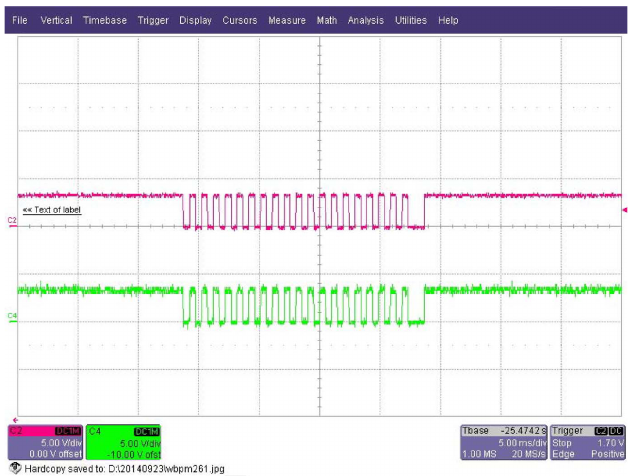
Figure 3 Two channels of control pulse signal output from the SLS2013: one is for the CCD93-70 step motor driver to control the Bragg motor of the DCM, the other is for the input signal of the scaler.